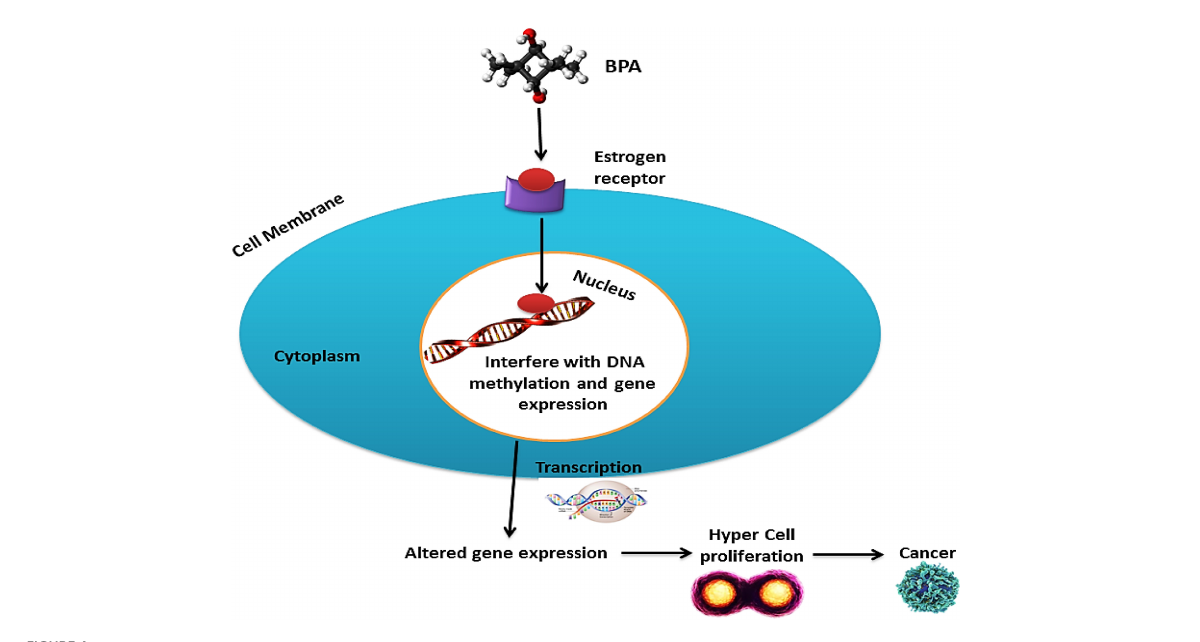
FIGURE4 Carcinogenic activity of BPA; BPA interacts with the estrogen receptors and interferes with DNA methylation and gene expression after entering the nucleus. Thus altered gene expression leads to hypercell proliferation, which may lead to cancer.